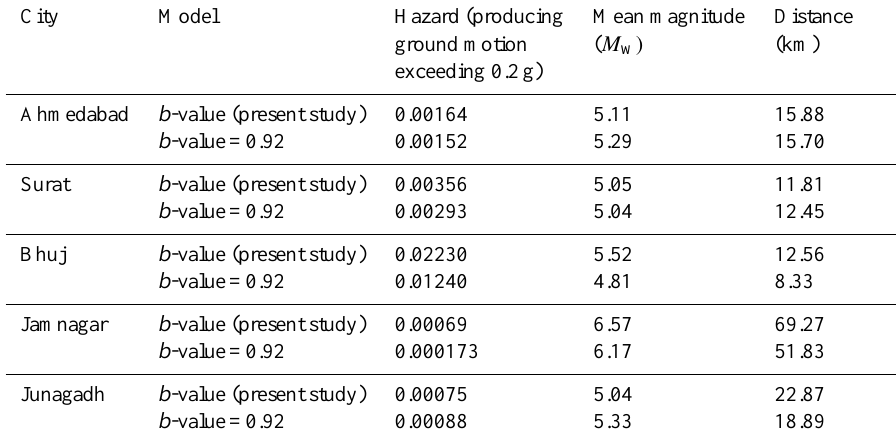
Table 5. Deterministic magnitude-distance pair for hazard-producing ground motion exceeding 0.2g.